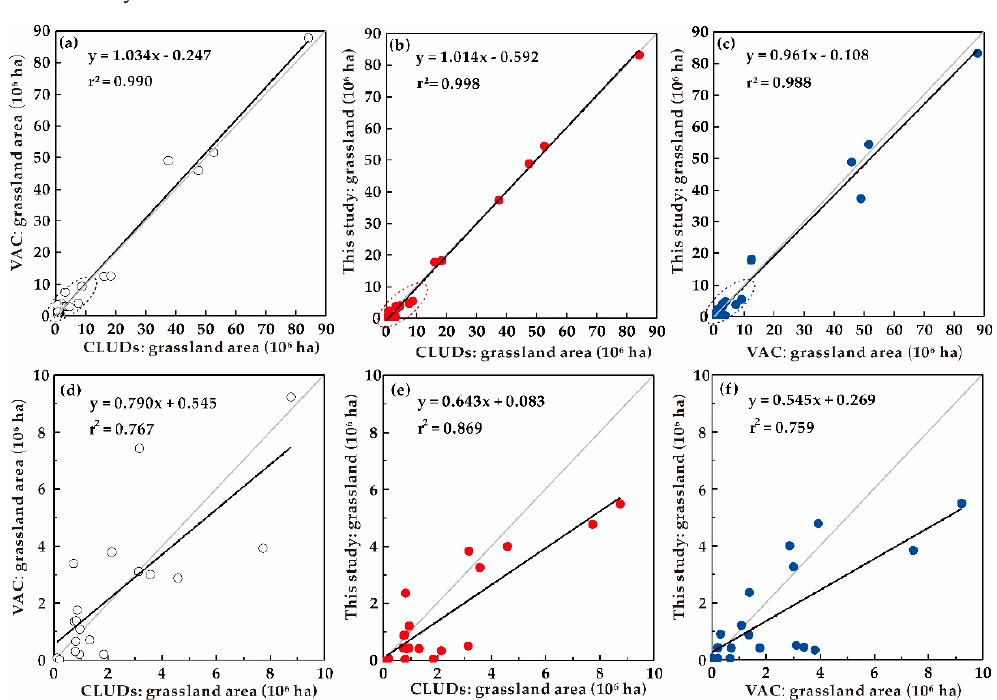
Figure 7. Provincial comparisons of grassland areas in 2000 derived from CLUDs (China’s land use / cover datasets), our reconstruction, and VAC (Vegetation Atlas of China). The correlations at the provincial scale: ( a ) the correlation between the VAC and CLUDs; ( b ) the correlation between our reconstruction and CLUDs; ( c ) the correlation between our reconstruction and VAC. The correlations among these datasets with the provincial grassland area less than 10.00 × 106 ha: ( d ) the correlation between the VAC and CLUDs; ( e ) the correlation between our reconstruction and CLUDs; ( f ) the correlation between our reconstruction and